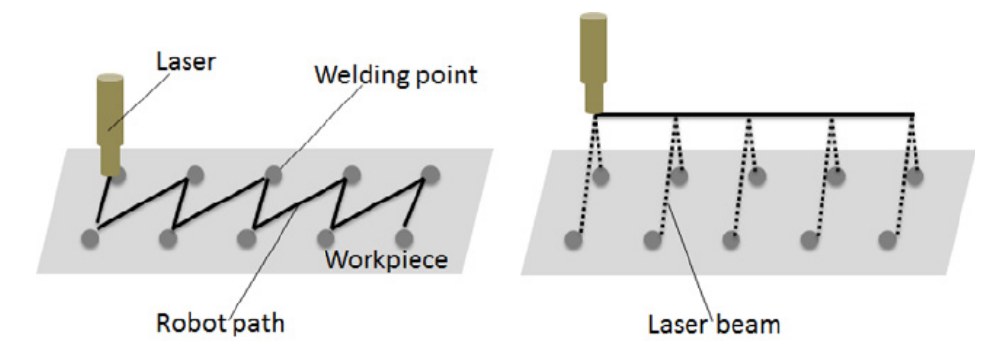
Figure 1. ( Left ) Short-distance welding path; ( Right ) remote welding path. The differences between short-distance and remote